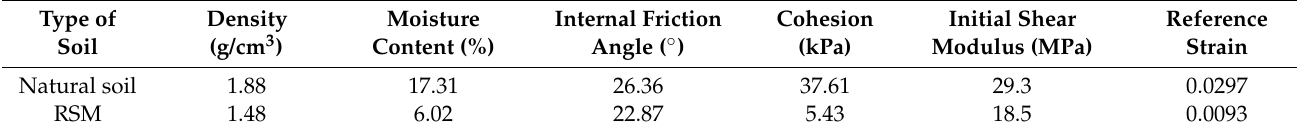
Figure 10. Mixing of rubber particles and sand. Table 4. Basic physical and mechanical parameters of soil.